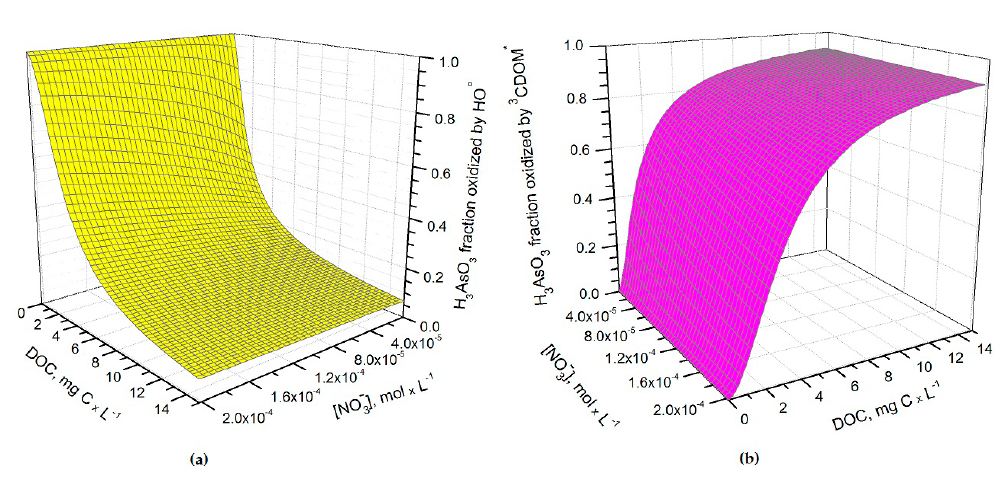
Figure 2. Fraction of H 3 AsO 3 transformed by ( a ) hydroxyl radicals and ( b ) CDOM triplet states ( 3 CDOM*) in May, as a function of nitrate and dissolved organic carbon (DOC). Water conditions: 5 cm depth, 1 μ M NO 2 − , 1 mM bicarbonate, and 10 μ M carbonate. Note that direct photolysis, carbonate radicals and singlet oxygen reactions were not taken into account in the model.